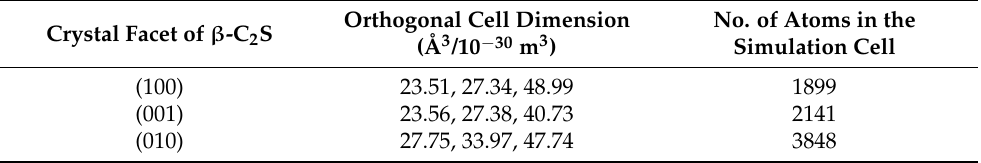
Table A1. Crystallographic data for the orthogonal simulation cells of β -C 2 S consisting of different crystalline facets at 298